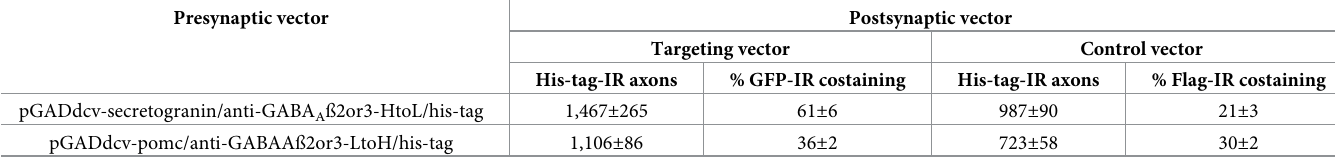
Table 2. Targeted gene transfer across GABA A ß2 or ß3-containing synapses; the percentage of transduced presynaptic axons proximal to a transduced postsynap- tic dendrite. Presynaptic